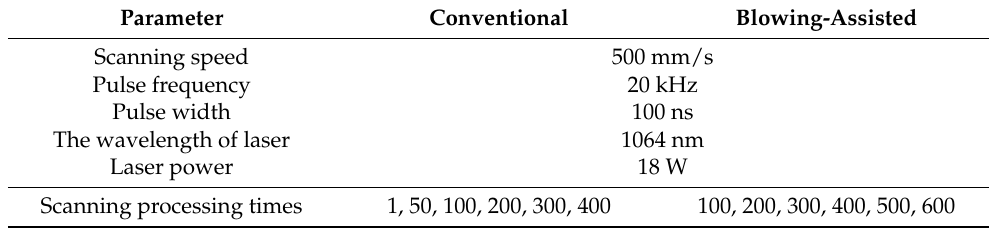
Figure 2. Schematic of the laser processing path. Table 2. Parameters in laser processing experiments.